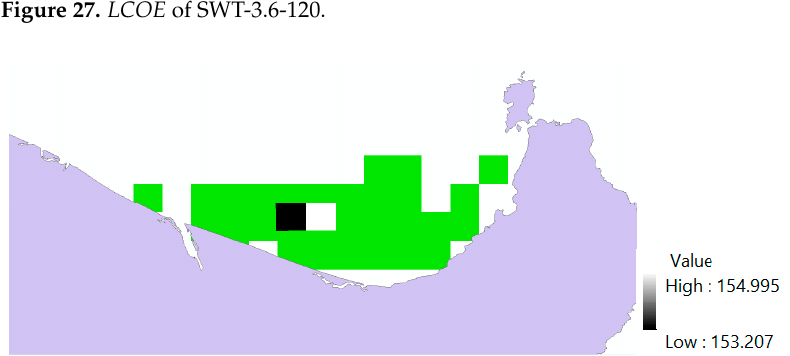
Figure 28. LCOE of 6.2M126.